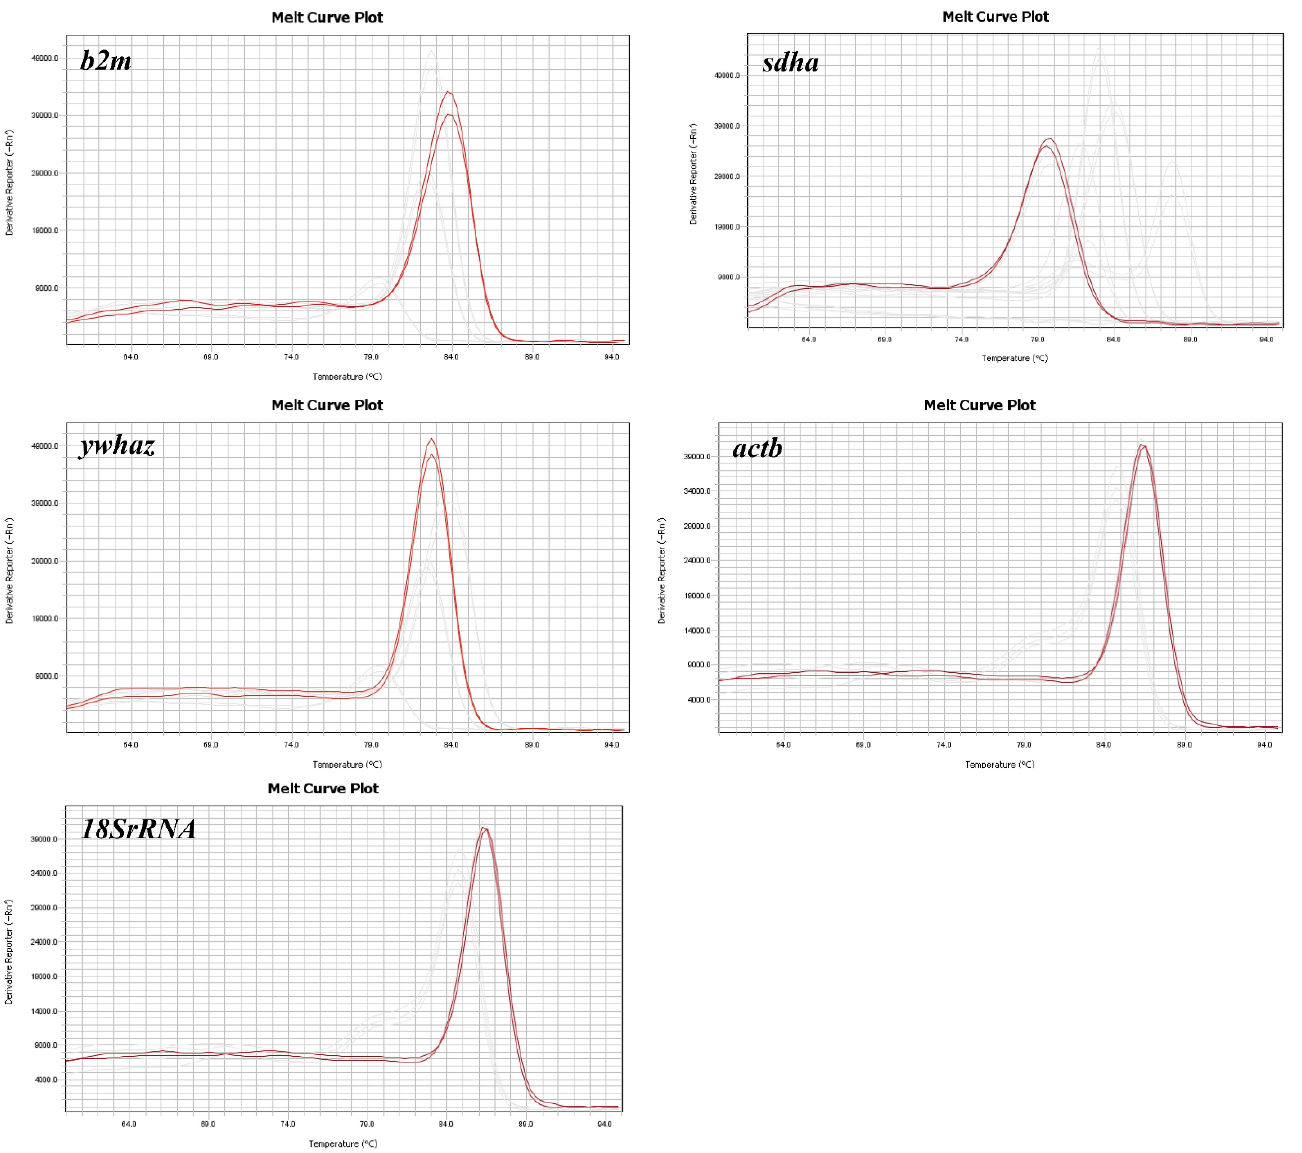
Figure 1. Melting curve of b2m , sdha , ywhaz , actb , and 18SrRNA gens in whole blood of cattle.